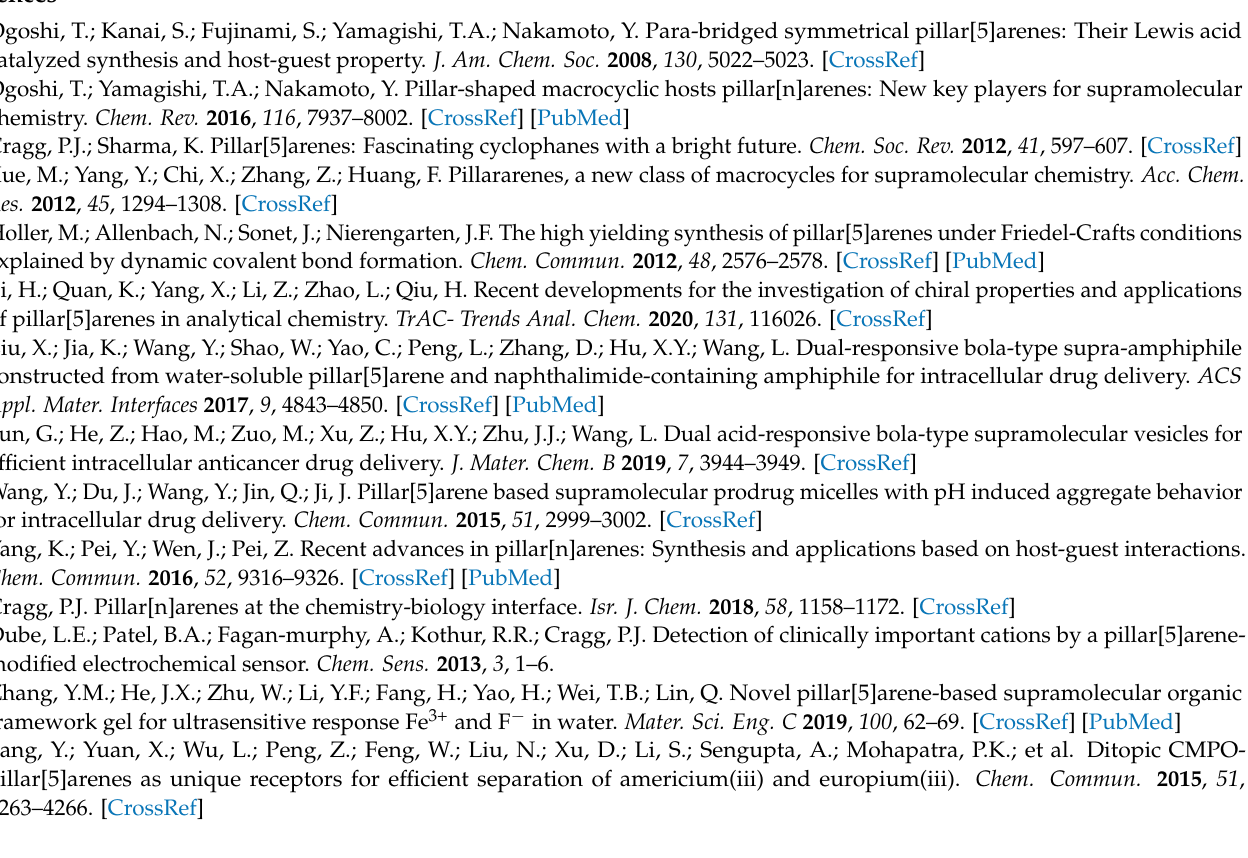
Figure S2. FT-IR spectrum of P4; Figure S3. FT-IR spectrum of P5; Figure S4. 1H-NMR spectrum of P2; Figure S5. 13C-NMR spectrum of P2; Figure S6. 1H-NMR spectrum of P4; Figure S7. 13C-NMR spectrum of P4; Figure S8. 1H-NMR spectrum of P5; Figure S9. 13C-NMR spectrum of P5; Figure S10. 3D PCA score plot; Figure S11. pH-sensitivity of the pillar[5]arene based potentiometric sensors. Table S1. Average sensitivities of the sensors calculated for all studied